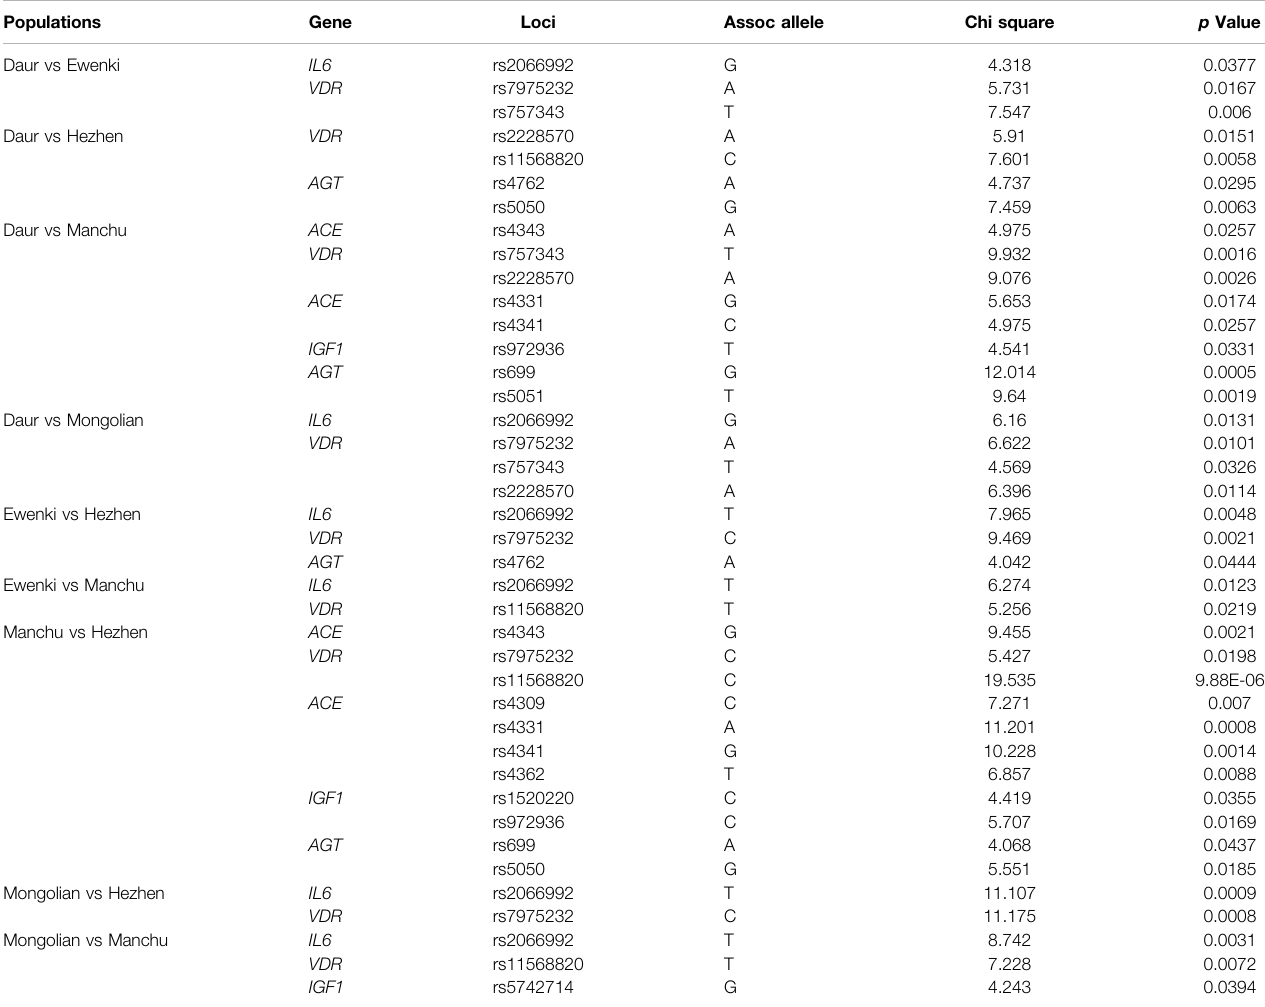
TABLE 3 | Summary statistical different SNPs after Pairwise comparison of fi ve populations. Populations Gene Loci Assoc allele Chi